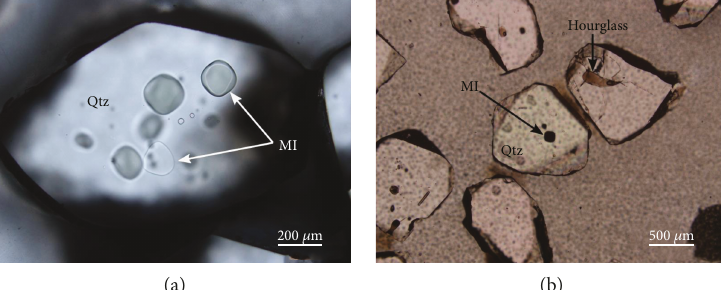
Figure 2: Melt inclusions (MIs) from Fukano Caldera. (a) Quartz crystal from the northern part of the caldera showing large, round colorless glassy inclusions in sample 160804-5 (Table 1 and Table 2). (b) Quartz crystals from the southern part showing rounded, dark crystalline inclusions in sample 160411-1a (Table 1 Table 2). The hourglass-type inclusions observed in the samples were not analyzed (see text for